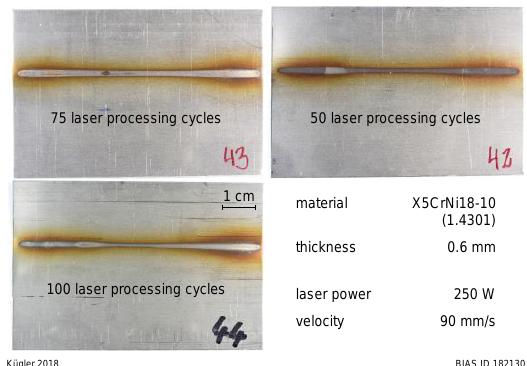
Figure 4. Surfaces of specimens with temper colors after laser processing. J. Manuf. Mater. Process. 2018 , 2 , x FOR PEER REVIEW